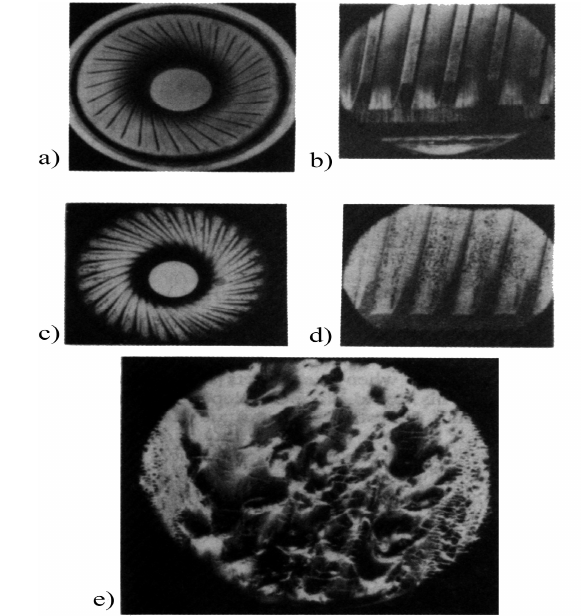
Figure 3 – Damage of the 105 mm M68 gun tube